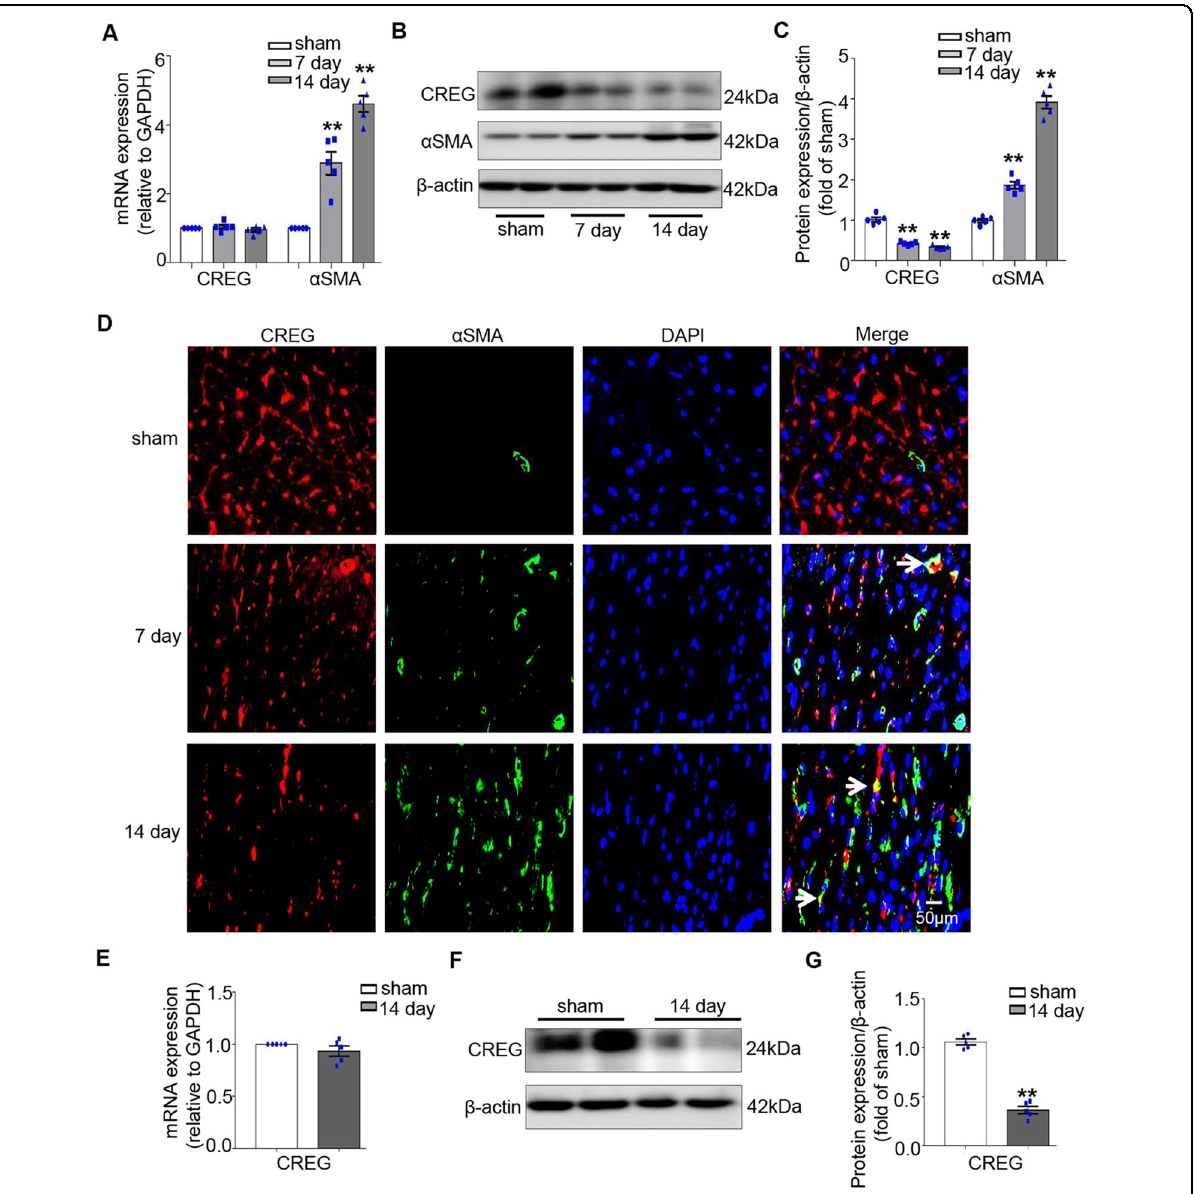
Fig. 1 CREG expression was decreased in the border zone of C57BL/6J mice after MI. A Real-time PCR of CREG and α SMA mRNA expression in the border zone of C57BL/6J mice on post-MI days 7 and 14 ( N = 5 per group). B , C Western blotting of CREG and α SMA protein expression in the border zone of C57BL/6J mice on post-MI days 7 and 14 ( N = 5 per group). D Immuno fl uorescence staining of CREG (red) and α SMA (green) expression in the border zone of myocardium in C57BL/6J mice on post-MI days 7 and 14 ( N = 3 per group). The arrow represented the co-location of CREG with α SMA. E Real-time PCR for CREG mRNA in primary cardiac fi broblast of MI group and sham group ( N = 5 per group). F , G Western blotting for CREG in primary cardiac fi broblast of MI group and sham group ( N = 5 per group). ** P < 0.01 vs. sham